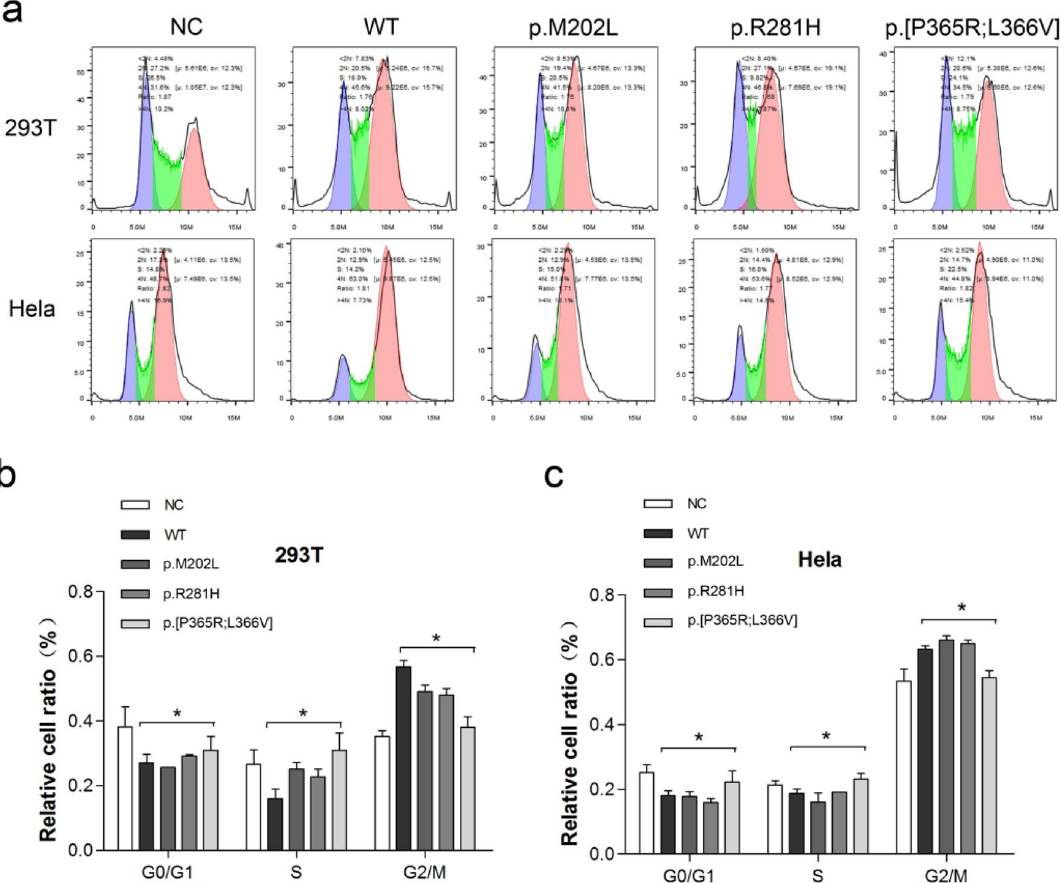
Figure 3. p.[P365R; L366V] ESX1 disrupted the inhibitory effect of ESX1 on cell cycle of 293 T and Hela cells. Wild type or mutant ESX1-HA expression vectors were transfected into cells as indicated. Empty vector was used as negative control (NC). Cells were synchronized at S phase with thymidine blocking for 36–48 h, then washed with PBS and treated with cytosine for another 6 h. ( a ) Cells were harvested and cell cycle profiles were analyzed by flow cytometry and the FlowJo software. The G0/G1, S, or G2 phase was marked with blue, green and pink colour, respectively. Relative cell ratio of different phases in 293 T ( b ) and Hela ( c ) generated by FlowJo from at least three independent experiments were analyzed statistically using GraphPad Prism 5 software. Compared with wild type ESX1, p.[P365R; L366V] ESX1 lost the ability to arrest cells at M phase. * P < For example, SIFT is an algorithm using sequence homology to predict whether a substitution affects protein function 19 . PolyPhen-2 uses eight sequenced-based and three structure-based predictive features which were automatically selected by an iterative greedy algorithm 20 . Of those six predictors used, four gave supportive results that the p.P365R mutation is a functional alteration. When the p.P365R mutation occurred, the original highly conserved proline is replaced by an alkaline residue, which might be deleterious to the configuration of ESX1 protein. Cyclins are key regulators of cell cycle control and play an essential role in both mitosis and meiosis dur- ing germ cell production. Mice lacking cyclin A1 and cyclin A2 exhibited male sterility and early embryonic lethality, respectively 23,24 . Our IP results showed that cyclin A could be successfully immunoprecipitated when ESX1 mutants overexpressed, suggesting that these mutations have no significant influence on the interaction between ESX1 and cyclin A. However, the polyubiquitination of cyclin A was decreased when p.P365R ESX1 was overexpressed, which means the ability to prevent the degradation of polyubiquitinated cyclin A by the proteo- some pathway was affected 18 . Cyclin A is transcriptionally activated in late G1 phase, then starts to accumulate in S phase. The consequence of compromised stability is that cyclin A might not stay that long in G2/M phase. According to the Human Protein Atlas, ESX1 is mainly expressed in the spermatogonia in human testis tissues (https ://www.prote inatl as.org/ENSG0 00001 23576 -ESX1/tissu e/testi s). Cyclins also play an important role in the proliferation of spermatogonia, therefore, the p.P365R mutation might exert a deleterious effect on spermatogo- nia proliferation during spermatogenesis, which further leads to spermatogenesis defects. This is consistent with the low testis volume and the SCO phenotype of the NOA patient harboring the p.P365R mutation. According to the single cell expression profile revealed by the Human Protein Atlas, ESX1 is specifically expressed in the spermatogonia of adult human testis. For patients W245 and W075, only Sertoli cells were observed in the testis. Therefore, their ESX1 mRNA levels were quite low.